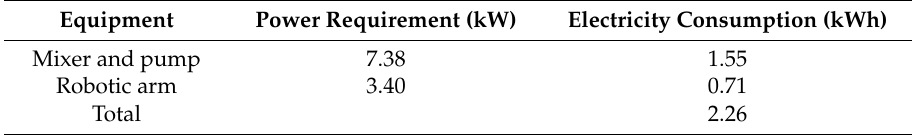
Table 4. Summary of the energy requirement during the construction phase in the 3DCP